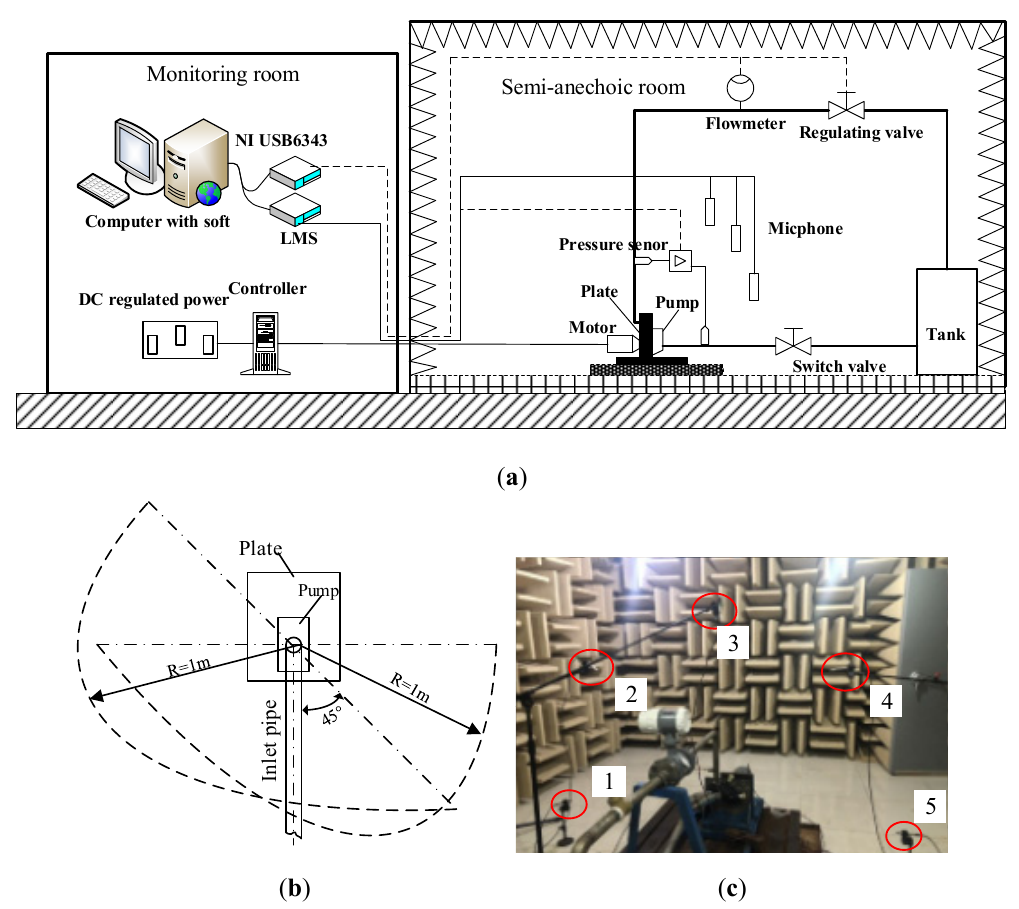
Figure 3. Test Rig: ( a ) test loop ( b ) microphone placement; ( c ) test scene.